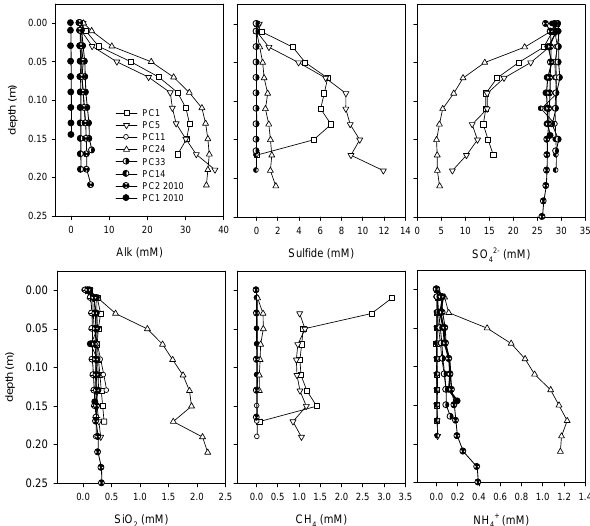
Fig. 4. Porewater chemistry profiles obtained from sediments re- trieved by the multicorer (MUC). The positions are given in Table 1. Fig. 4 The data from the reference site, approximately 550m southwest of the vents, are indicated with black symbols. The other cores are from the Abyss Vent area. MUC 10 is the only core among all sedi- ments sampled that showed sulfate depletion.